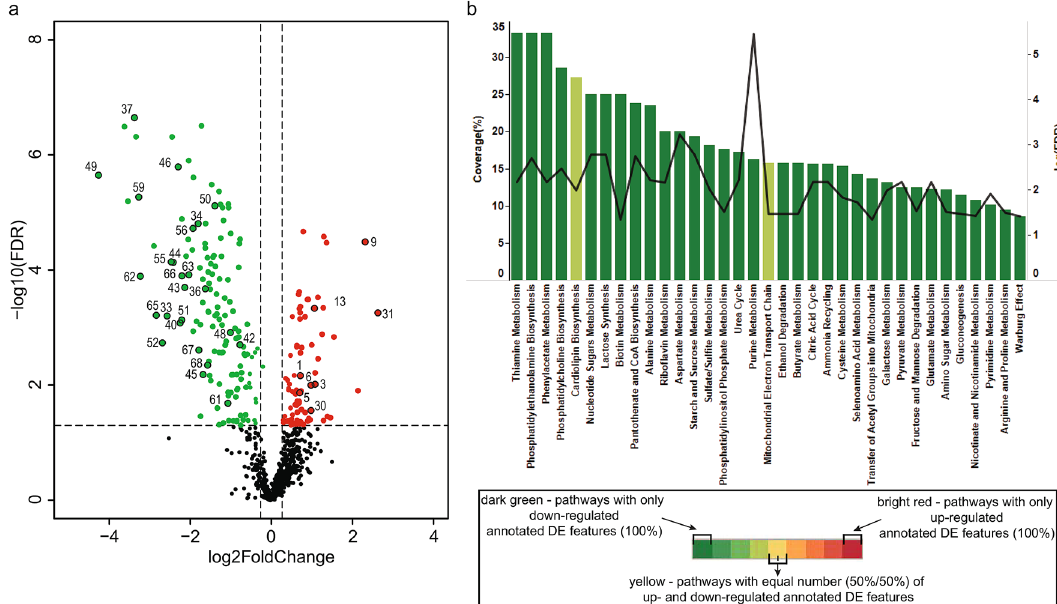
Figure 4. Exploratory analysis of data at 15 min of ischemia. ( a ) Volcano plot showed the profile of changes in the myocardial tissue metabolome at 15 min. The significantly altered features were colour coded respecting the selection threshold of FDR < 0.05 (horizontal dashed line); green and red dots represent significantly down- and up-regulated features, respectively. Statistical calculations were done using MetaboAnalyst software. Annotated features are highlighted by numbers, which correspond to their name in Supplementary Tables S5 and S6 online. ( b ) Functional enrichment analysis of the annotated features represented by bar graph showed